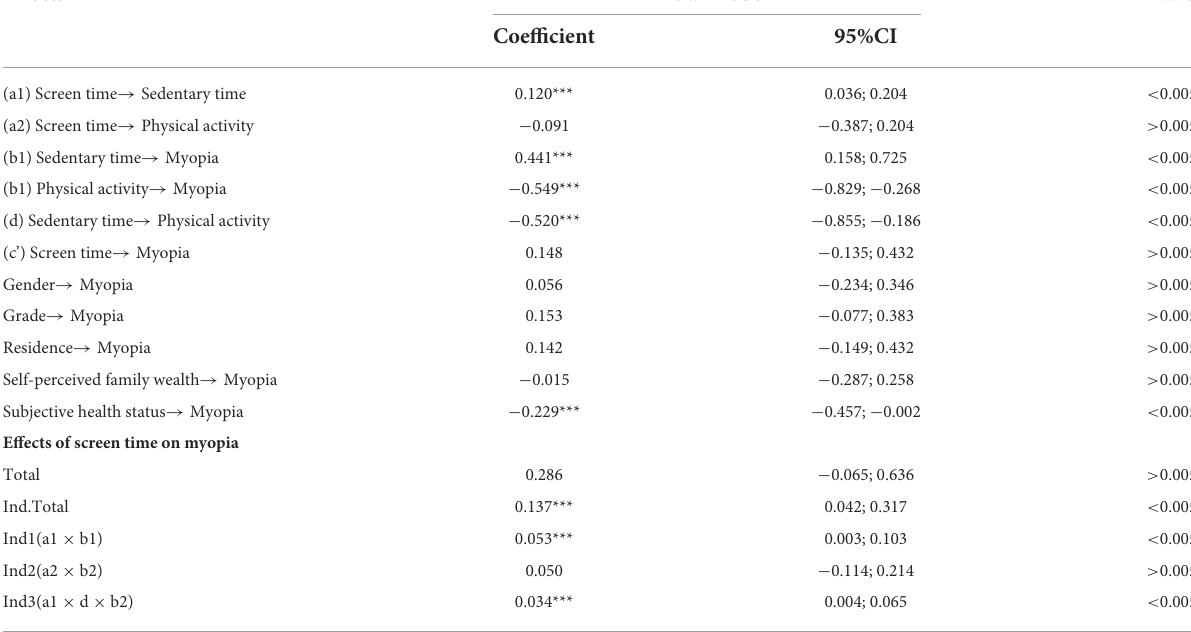
TABLE 3 Coefficients and significance tests for the explanatory model